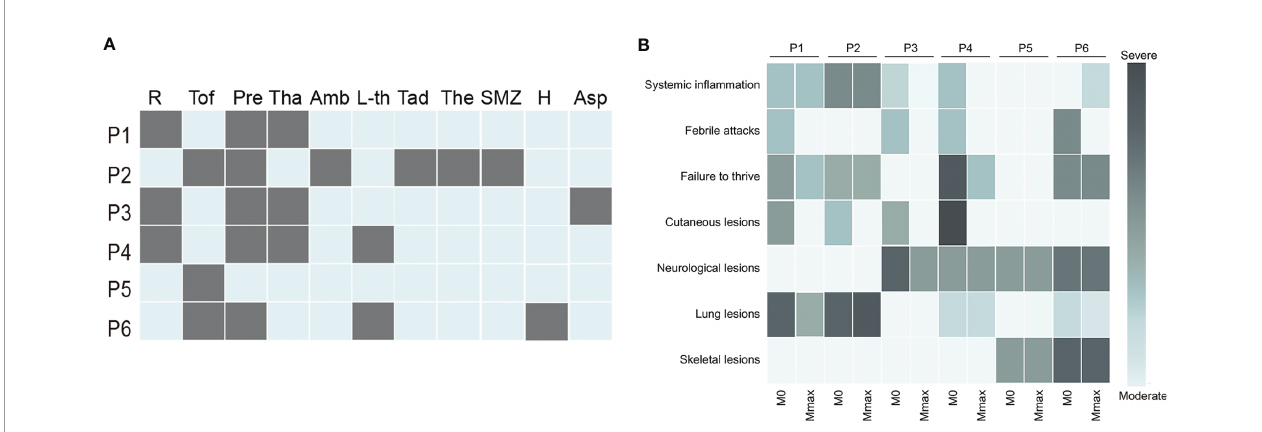
FIGURE 2 | Treatment and prognosis of patients with IFNopathies. (A) The treatment of patients with IFNopathies. Each row represents a patient, and each column represents a drug. A grey box indicates the presence of this treatment. (B) The change of clinical manifestations before and after jakinib treatment. Each row represents a manifestation, and each column represents a patient. The shade of color indicates the severity of the symptoms. The light blue box represents the absence of this symptom. P, patient; R, ruxolitinib; Tof, tofacitinib; Pre, prednisone; Tha, thalidomide; Amb, ambrisentan; L-th, levothyroxine sodium; Tad, tadala fi l; The, theophylline; SMZ, sulfamethoxazole; H, hydroxychloroquine; Asp, aspirin; M0, the time before jakinibs treatment; Mmax, the time at the last follow-up